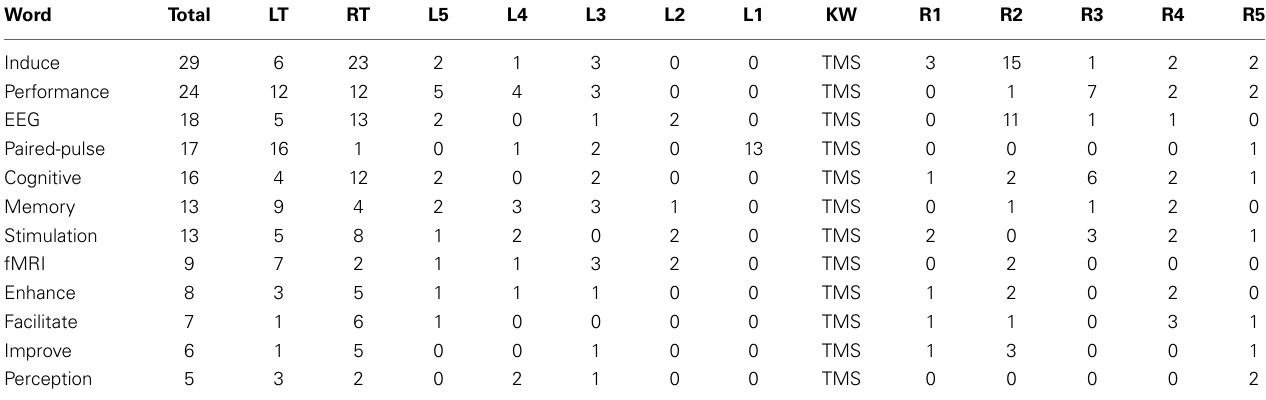
Table 4 | KWIC examples for